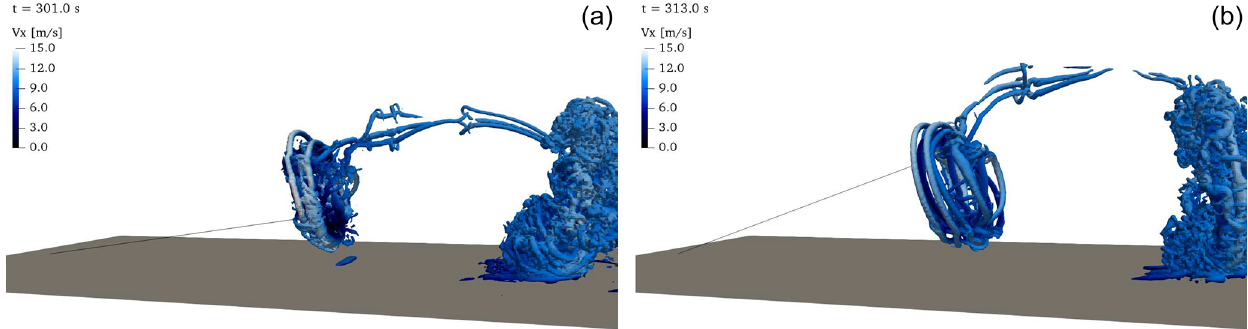
Figure 8. Instantaneous lateral snapshots of the wake field of reference lift-mode AWE systems operating in an unperturbed logarithmic inflow at a wind speed U D = 10ms − 1 . Isovolumes of positive Q criterion, coloured by streamwise velocity (cid:101) v x for (a) lift-mode AWE system with original bounds at t = 301s and (b) lift-mode AWE system with induction-based limitation of reel-out speed at t = 313s.